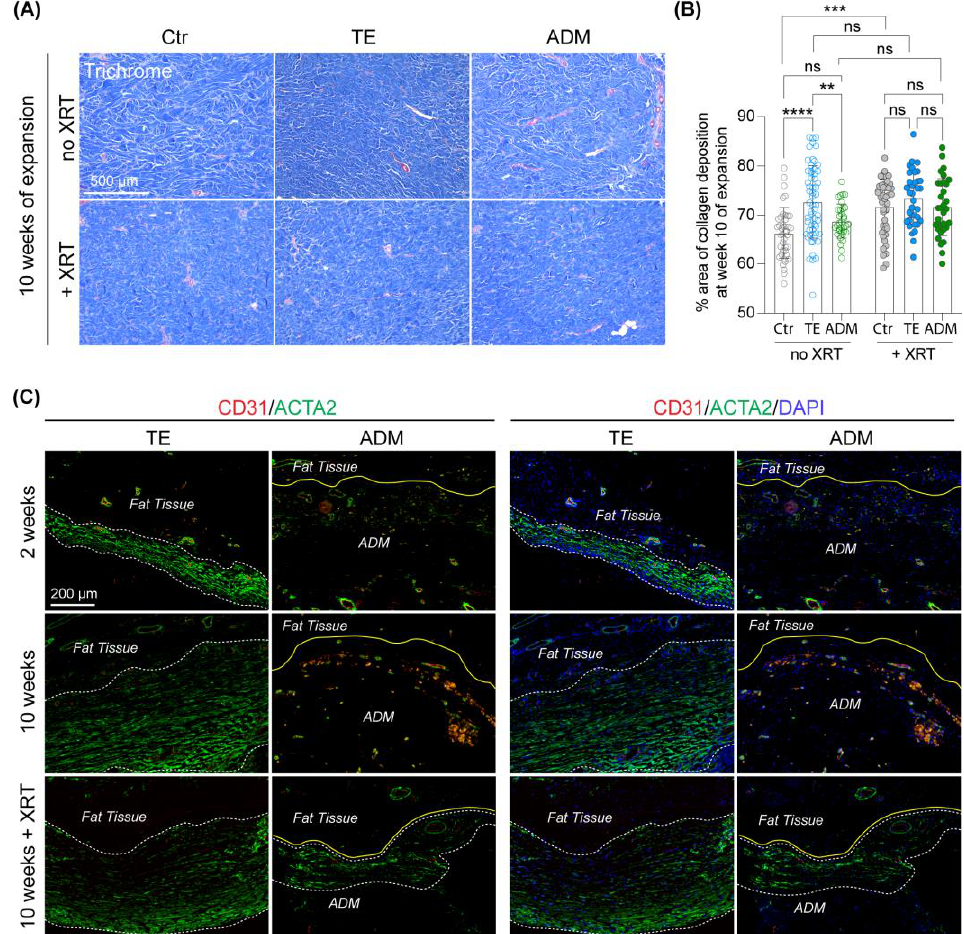
Figure 3. Biological cover prevents excessive collagen deposition and capsule formation in ex- panded non-irradiated skin. ( A ) Representative images and ( B ) quantitative analysis of trichrome staining of non-irradiated (no XRT) and irradiated (+XRT) skin samples at 10 weeks of expansion. Ctr, unexpanded control skin; TE, skin expanded without a biological cover; ADM, skin expanded with a biological cover. Magnification 10× . Scale bars 500 μm. Error bars represent SD. Statistical significance calculated with ordinary one-way ANOVA with Bonferroni correction for multiple comparisons is shown as ** p - value ≤ 0.01, *** p - value ≤ 0.001, **** p - value ≤ 0.0001 , ns – not statisti- cally significant. ( C ) Representative images of double immunofluorescence staining of CD31 and ACTA2 on tissue that was in close proximity to the tissue expander alone (TE model) or covered with a biological matrix (ADM model). Tissue samples were collected from non-irradiated skin at 2 and 10 weeks of expansion, and from irradiated skin at 10 weeks of expansion. White dashed lines outline the capsule formed above the tissue expander. Yellow lines mark the region where ADM is attached to host tissue.